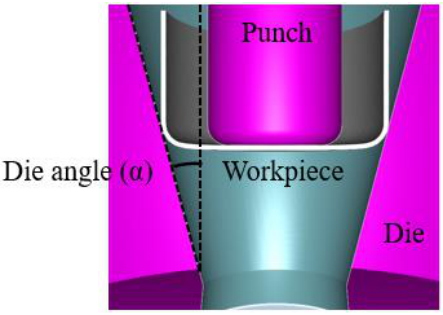
Figure 6. Die angle (α) between material and die .